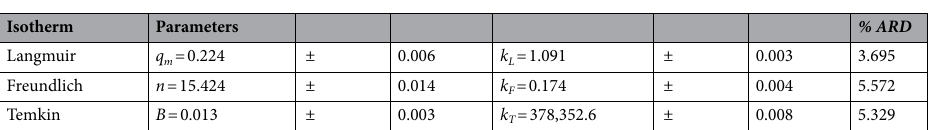
Table 1. The evaluated parameters of adsorption isotherm models with the corresponding ARD from the experimental data.